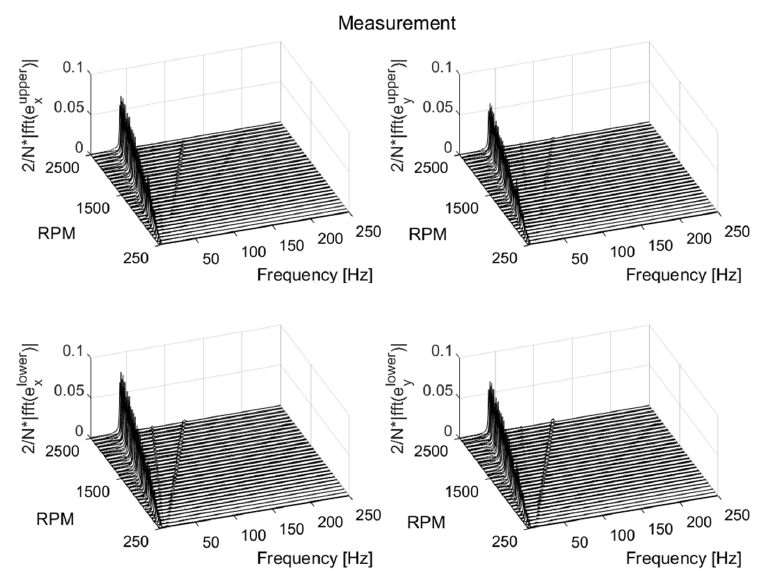
Figure 24. The waterfall diagram of the measured shaft displacement with 5.9 × 10 − 3 kg·m and 2 π rad/s 2 . N is the number of samples.